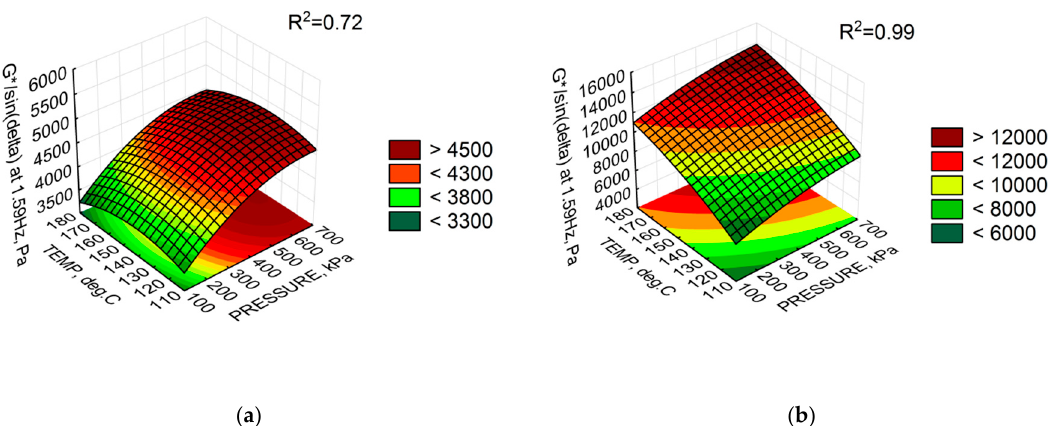
Figure 7. Response surface of G*/sin( δ )at the 2.5% water content: ( a ) bitumen 50/70; and ( b ) bitumen 50/70